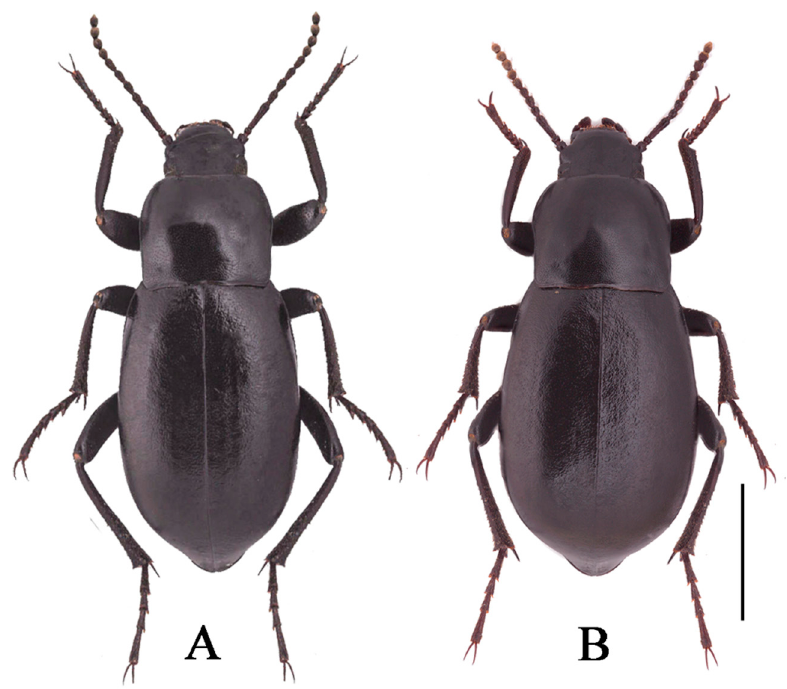
Figure 10. Habitus of N. xinlongensis sp. n. (( A ) male, holotype; ( B ) female, paratype). Scale bars: 5.0 mm.